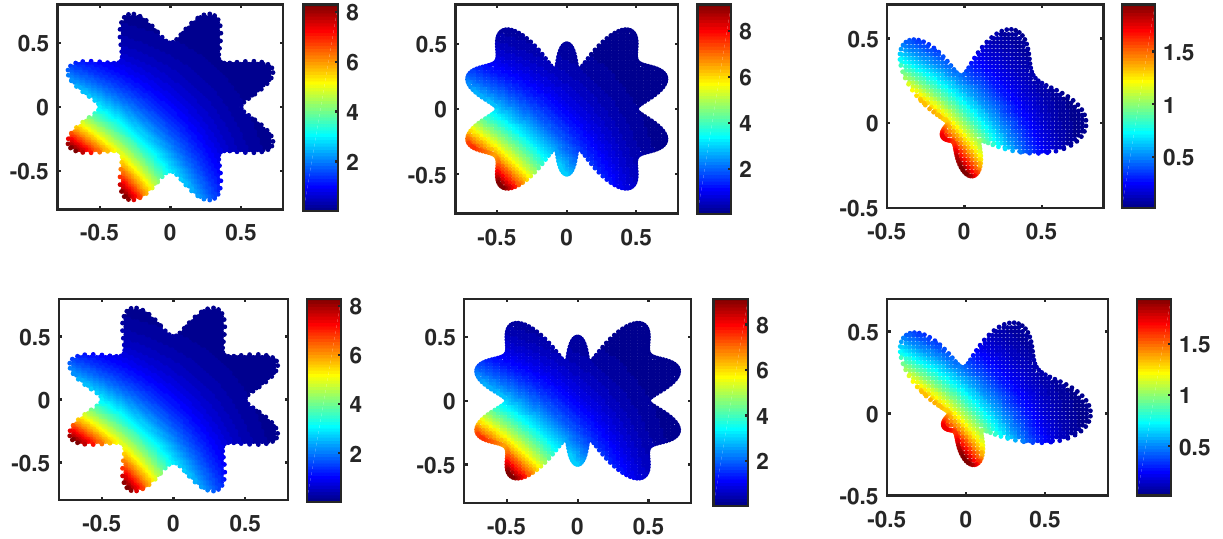
Figure 10. Contour plot of (first row) numerical and (second row) analytical solutions at T = 1, with τ = 0.1 in Ω 1 , Ω 2 , and Ω 3 for Example